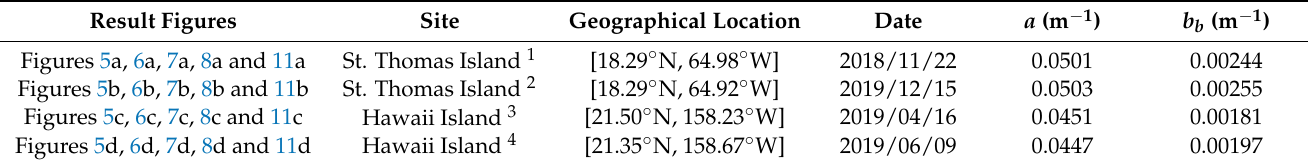
Figure 4. ( a ) Locations of the two study areas used to verify the water forward-scattering bias model. ( b ) ICESat-2 ground tracks at St. Thomas island. ( c , d ) ICESat-2 ground tracks at Hawaii. In all image subfigures (from Sentinel-2 images), green lines represent the ICESat-2 tracks. Table 2. Information of ICESat-2 tracks and intrinsic optical parameters of local water from MODIS